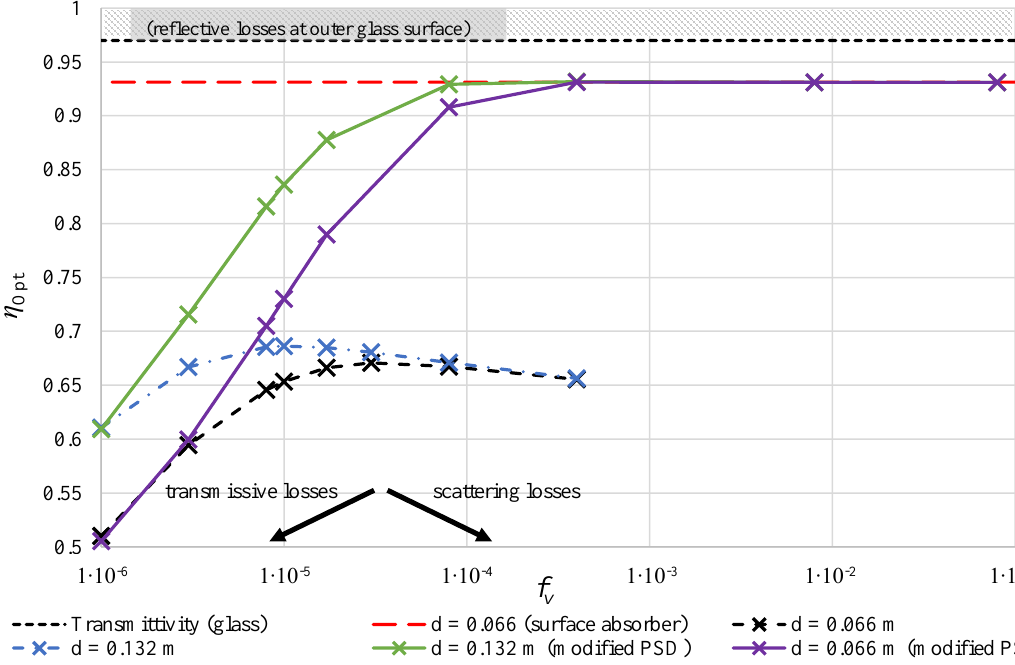
Figure 3. At some point, the benefit of better absorption due to an increase of f V reverts and optical losses due to scattering deteriorate the optical efficiency (dashed lines). For very small particle size distributions (solid lines), less radiation is scattered so that very high absorption rates can be